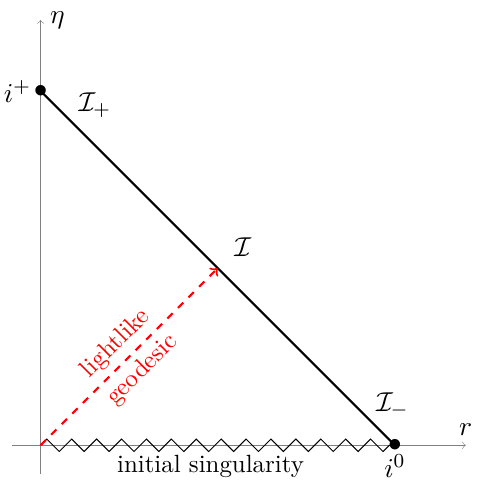
Figure 1 . Conformal diagram of decelerating and spatially flat FLRW spacetimes. Points on I are accessible by keeping u constant and taking the limit r → ∞ . Adopting next the limits u → ±∞ , one reaches the early and late time boundaries I ±